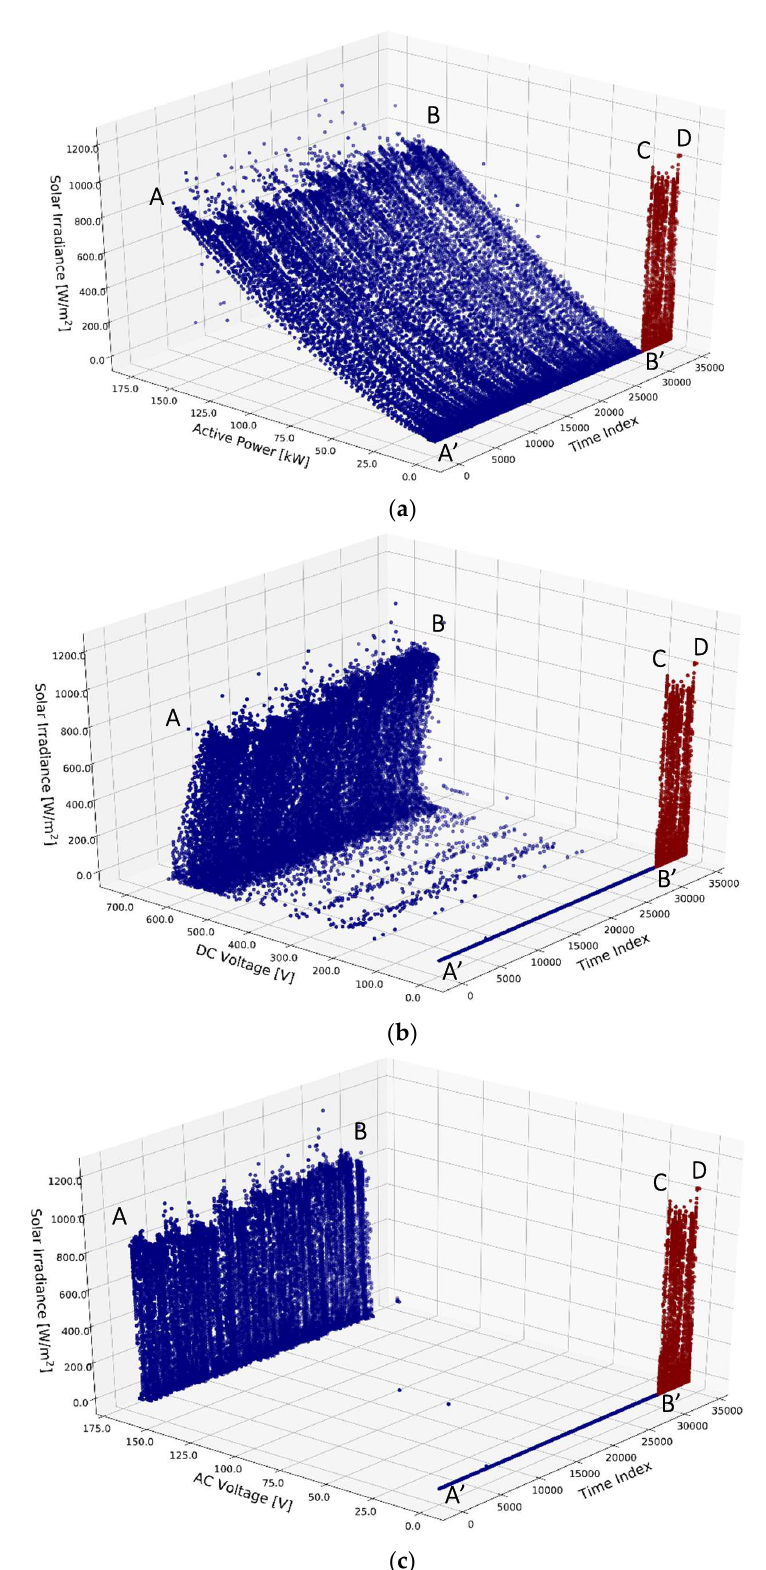
Figure 6. Exploratory data analysis applied to sensor signals from block A of the inverter 1. Trends of ( a ) active power, ( b ) DC voltage and ( c ) AC voltage (x-axis), against solar irradiance (y-axis) and time (z-axis).